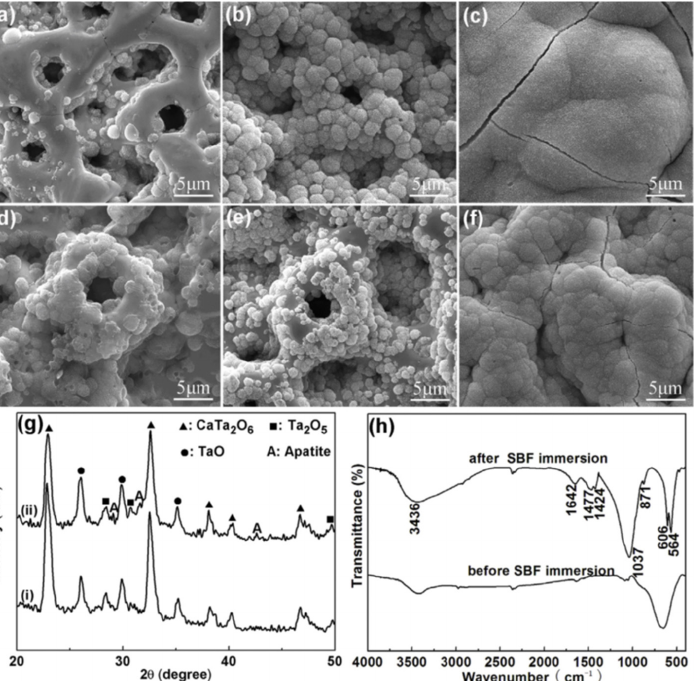
Figure 18. Surface morphologies of Ta 2 O 5 modified by MAO at 450 V after immersion in SBF for ( a ) 32, ( b ) 36, and ( c ) 40 days; surface morphologies of the Ta 2 O 5 modified by MAO annealed at 800 ◦ C formed at 450 V after immersion in SBF for ( d ) 9, ( e ) 12, and ( f ) 18 days; ( g ) XRD patterns of the MAO-treated surface formed at 450 V before (i) and after (ii) immersion in SBF for 40 days; ( h ) FTIR spectra of the MAO-treated surface formed at 450 V before and after immersion in SBF for 40 days. Reproduced with permission from Ref. [69]. Copyright 2016